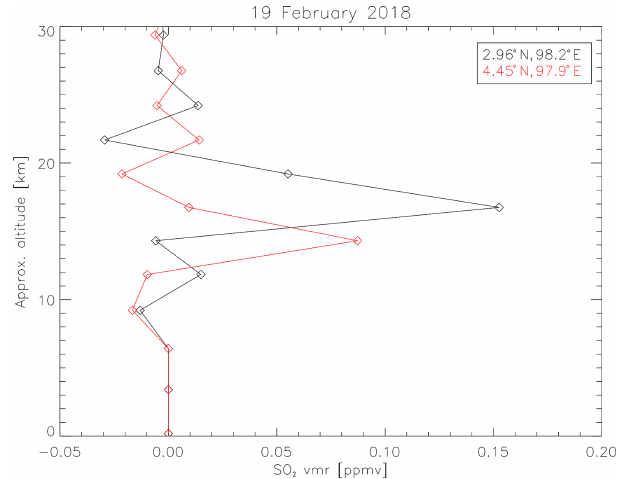
Figure 8. MLS SO 2 profile for two measurements intersecting the volcanic plume of the Sinabung volcanic eruption on 19 Febru- ary 2018, clearly showing the presence of an SO 2 layer at an altitude of around 16km close to the volcano (black) and 13km in the ex- tended plume farther north (red). The position of the measurements is shown in Fig.